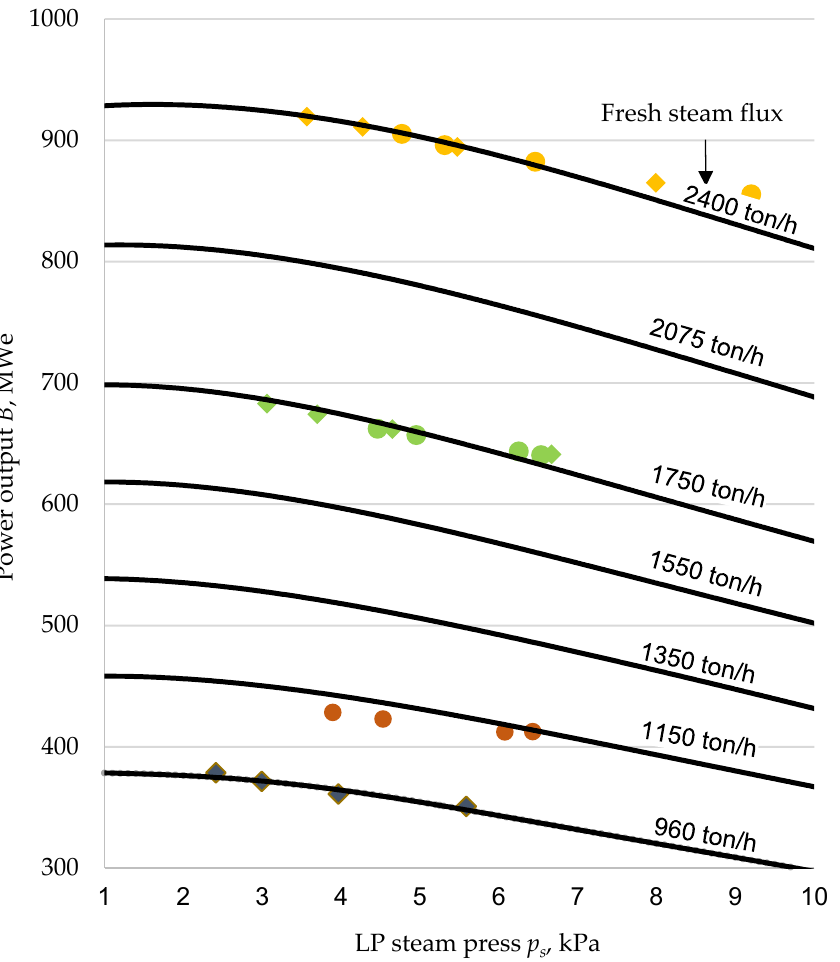
Figure 12. Dependence of unit power on fresh steam flux and condenser pressure for different values of fresh steam flux (theoretical curves are marked with lines, and in-service measurement results are marked with points) .